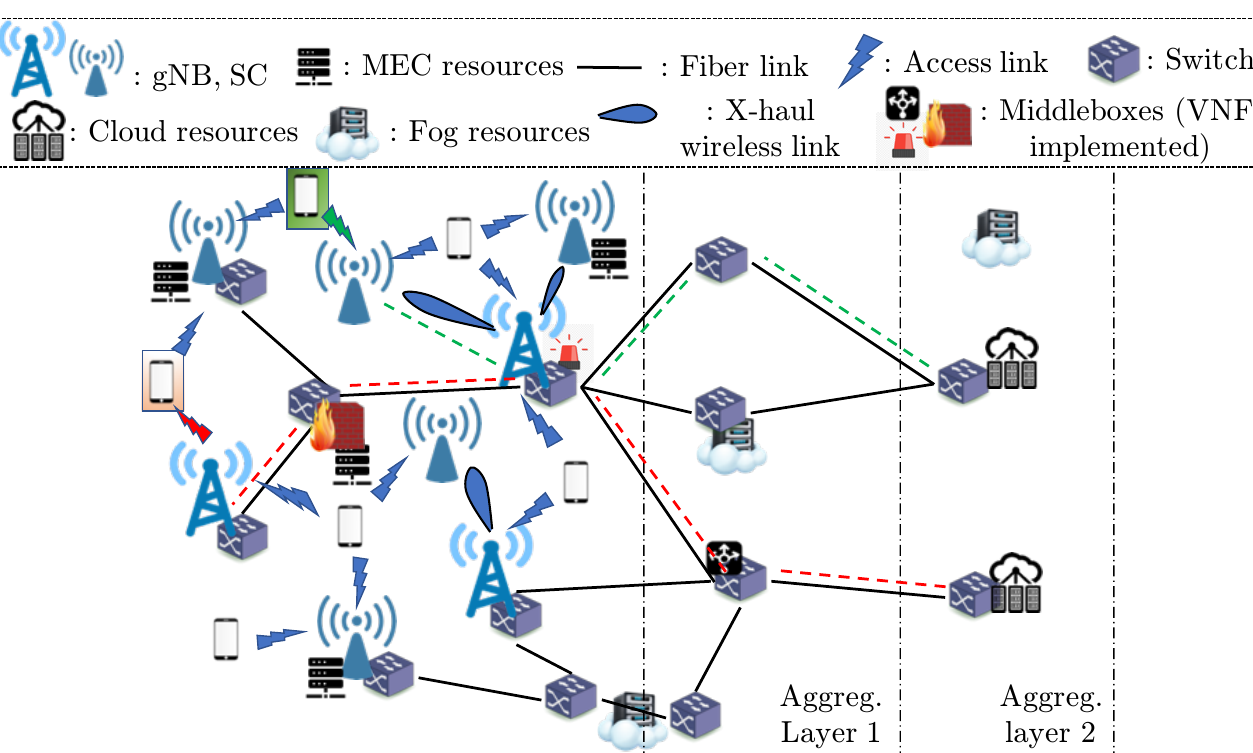
Figure 1. Mobile network of heterogeneous communication and computation nodes along with middlebox functionality offered by deployed VNFs. Dashed color lines indicate 2 illustrative E2E paths selected for 2 highlighted